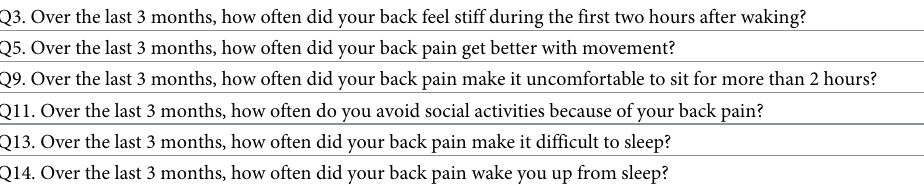
Table 6. List of questions included in the final proposed screening tool. Q3. Over the last 3 months, how often did your back feel stiff during the first two hours after waking? Q5. Over the last 3 months, how often did your back pain get better with movement? Q9. Over the last 3 months, how often did your back pain make it uncomfortable to sit for more than 2 hours? Q11. Over the last 3 months, how often do you avoid social activities because of your back